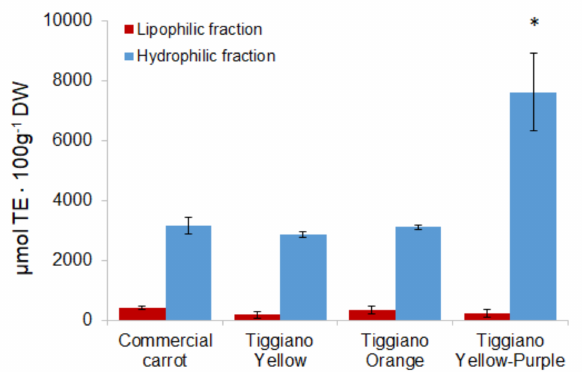
Figure 5. Antioxidant profile of Tiggiano carrots compared to a commercial cultivar. Significance assumed at * p <